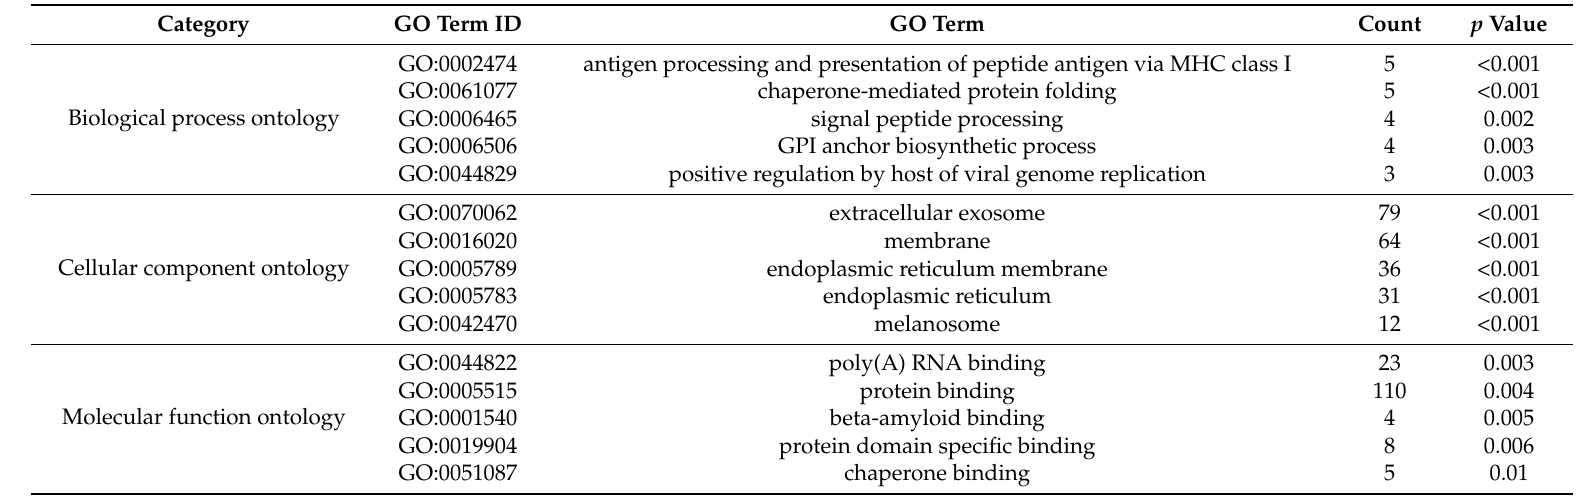
Table 6. Enriched Kyoto Encyclopedia of Genes and Genomes (KEGG) pathways of the down-regulated genes in parathyroid adenomas. Term ID